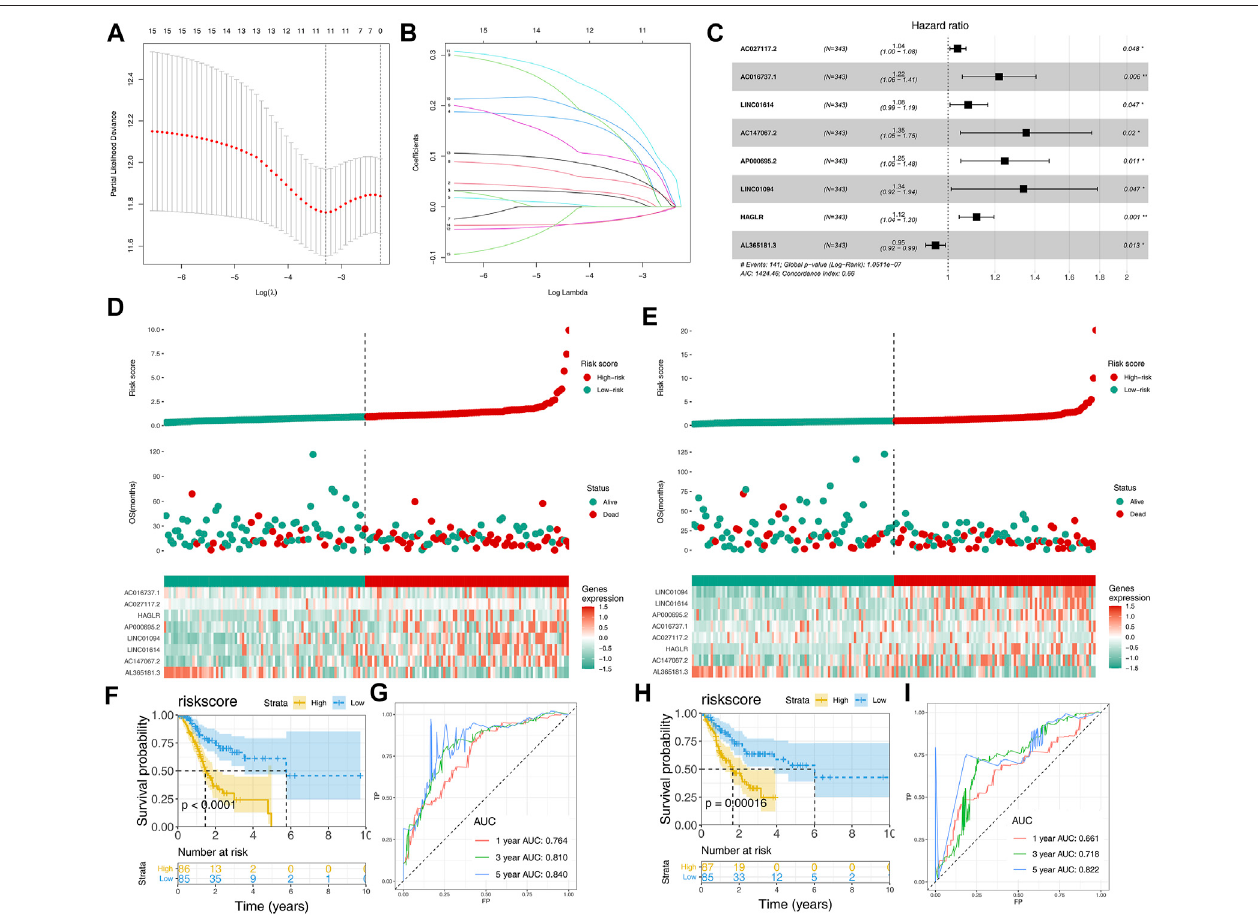
FIGURE3| ConstructionandvalidationoftheCML-basedprognosismodel. (A,B) :Lassoregressionanalysiswasperformedtoconductdimensionreduction; (C) : MultivariateCoxregressionanalysiswasperformedtoconstructaprognosticmodelwith p < 0.05andthemodelgenesincludeAC027117.2,AC016737.1,LINC01614, AC147067.2,AP000695.2,LINC01094, HA,GLRandAL365181.3; (D) :Riskplotofpatients inthetrainingcohort; (E) :Riskplotofpatients inthevalidationcohort; (F,G) : Kaplan – Meier survival and ROC curves in the training cohort; (H,I) : Kaplan – Meier survival and ROC curves in the validation